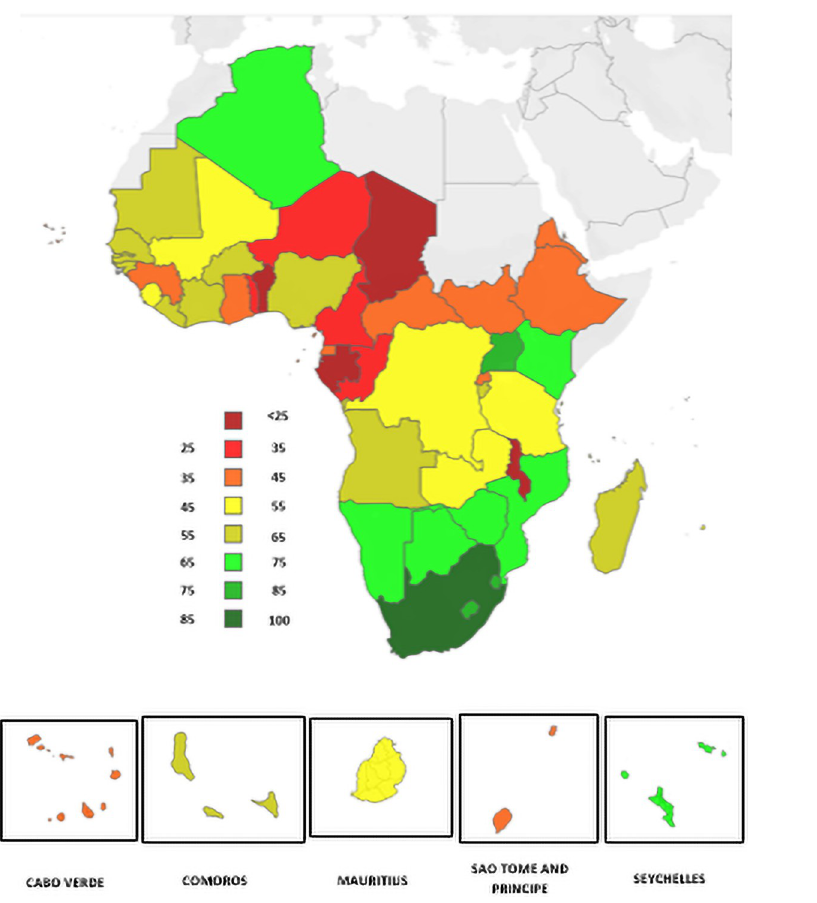
Fig 3. Relative resilience by country of the WHO African